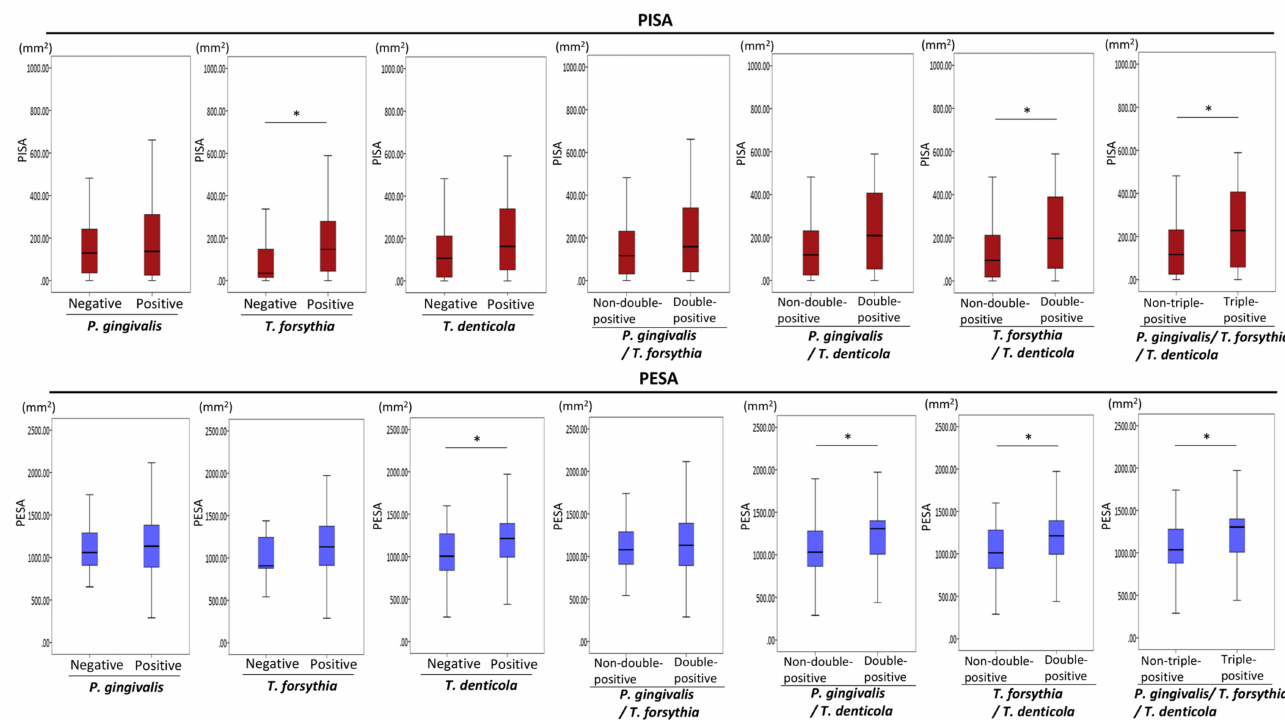
Figure 3. Associations of periodontopathic bacteria with PISA and PESA. Mann–Whitney U test. Statistical significance levels of p < 0.05 are indicated by